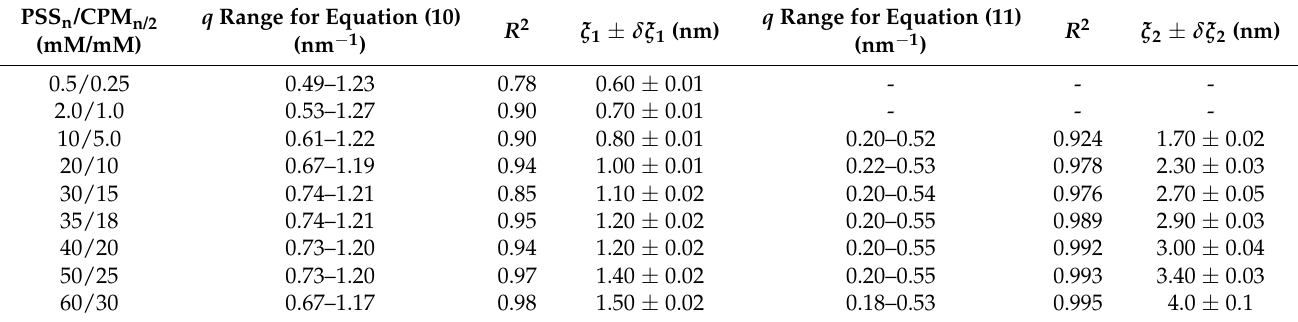
Table 2. ξ 1 and ξ 2 correlation lengths for different PSS n /CPM n/2 system formulations. PSS n /CPM n/2